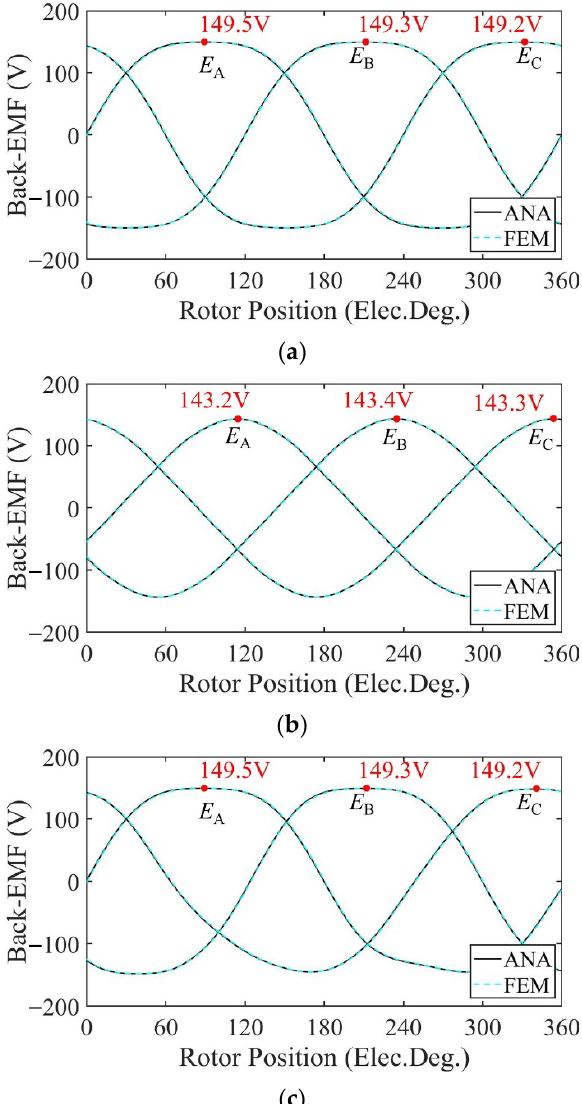
Figure 12. Back-EMF comparison. ( a ) Healthy; ( b ) uniform demagnetization; ( c ) partial demagnetization.